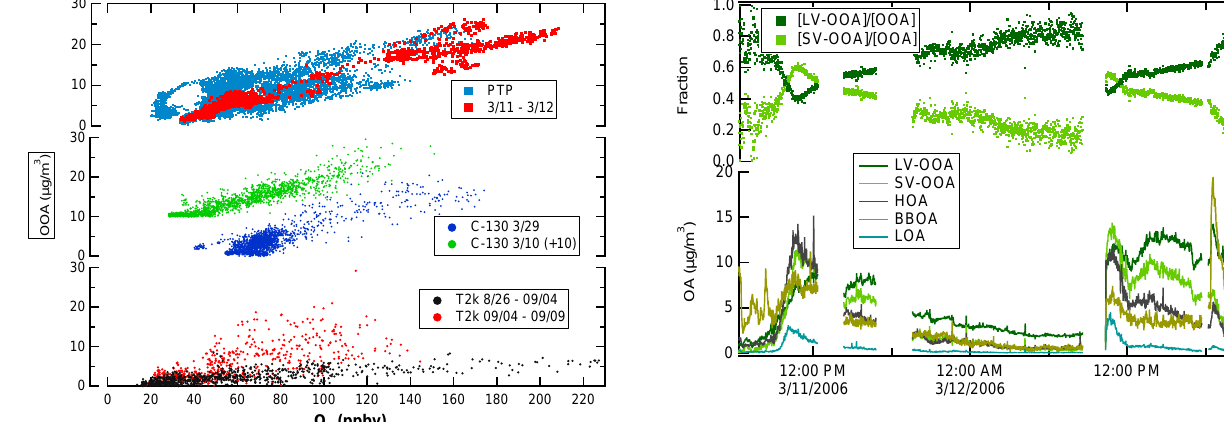
Fig. 4. Time series of the OA PMF components (lower graph), and fractional contribution of LV-OOA and SV-OOA to total OOA (up- per graph) at PTP on 11 and 12 March